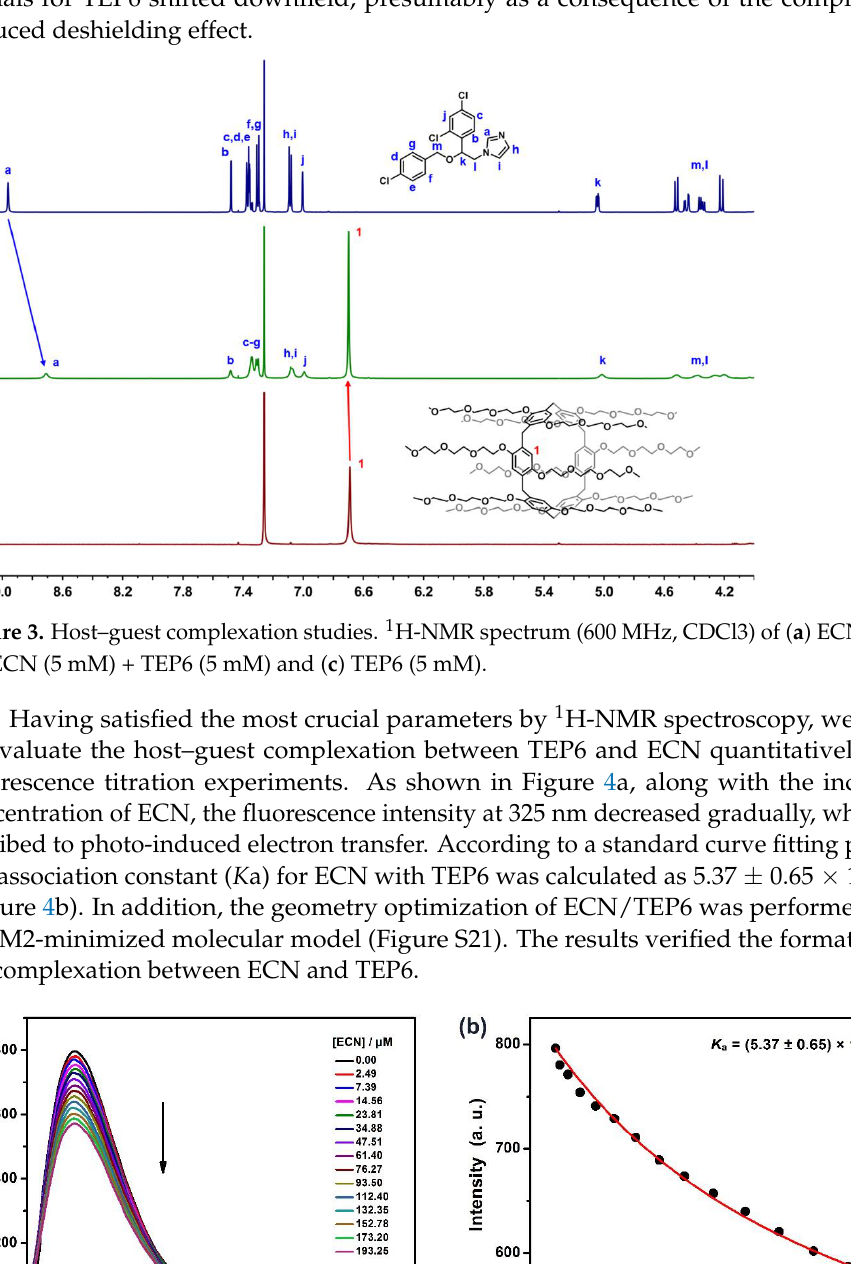
Figure 4. ( a ) Fluorescence titration of TEP6 (1 μM) with ECN in water/methanol (30/70, v / v ), λ ex = 290 nm. ( b ) The associated titration curve at λ em = 325 nm and fit according a 1:1 binding stoichi- ometry.